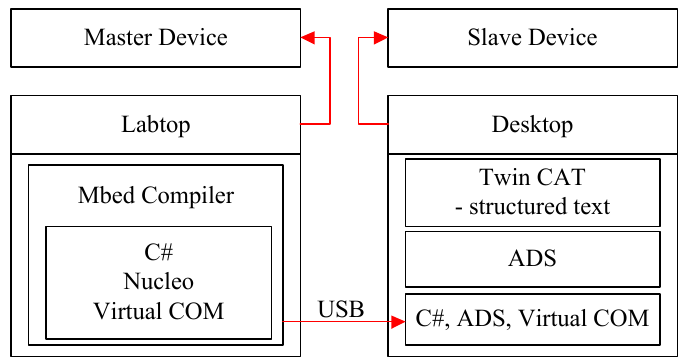
Figure 6. Schematic diagram of the proposed teleoperation system.